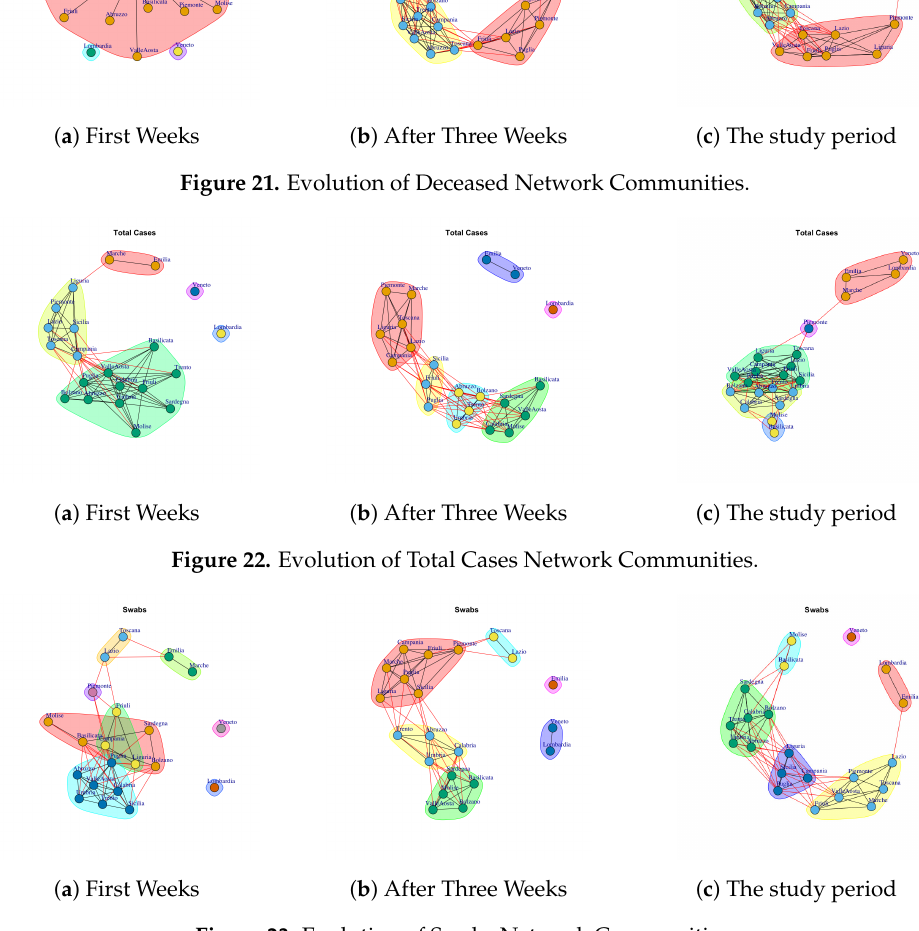
Figure 23. Evolution of Swabs Network